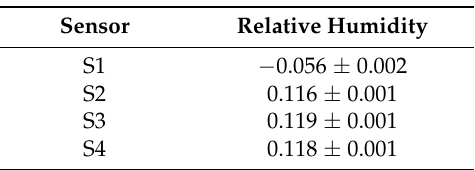
Table 2. Fixed effects regression coefficients of relative humidity vs. sensors. Values indicate mean fixed effect regression coefficients ± their 95% confidence intervals.